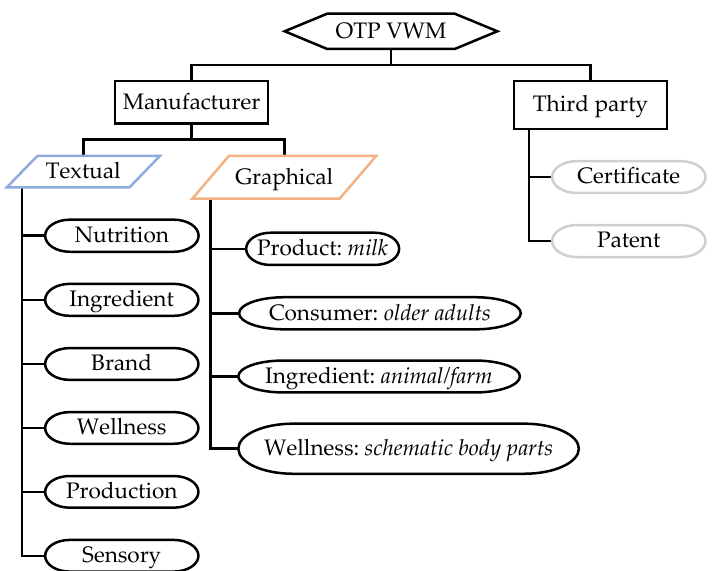
Figure 1. Classification of on-the-pack (OTP) voluntary well-being messaging (VWM) on milks targeting Chinese older adults.